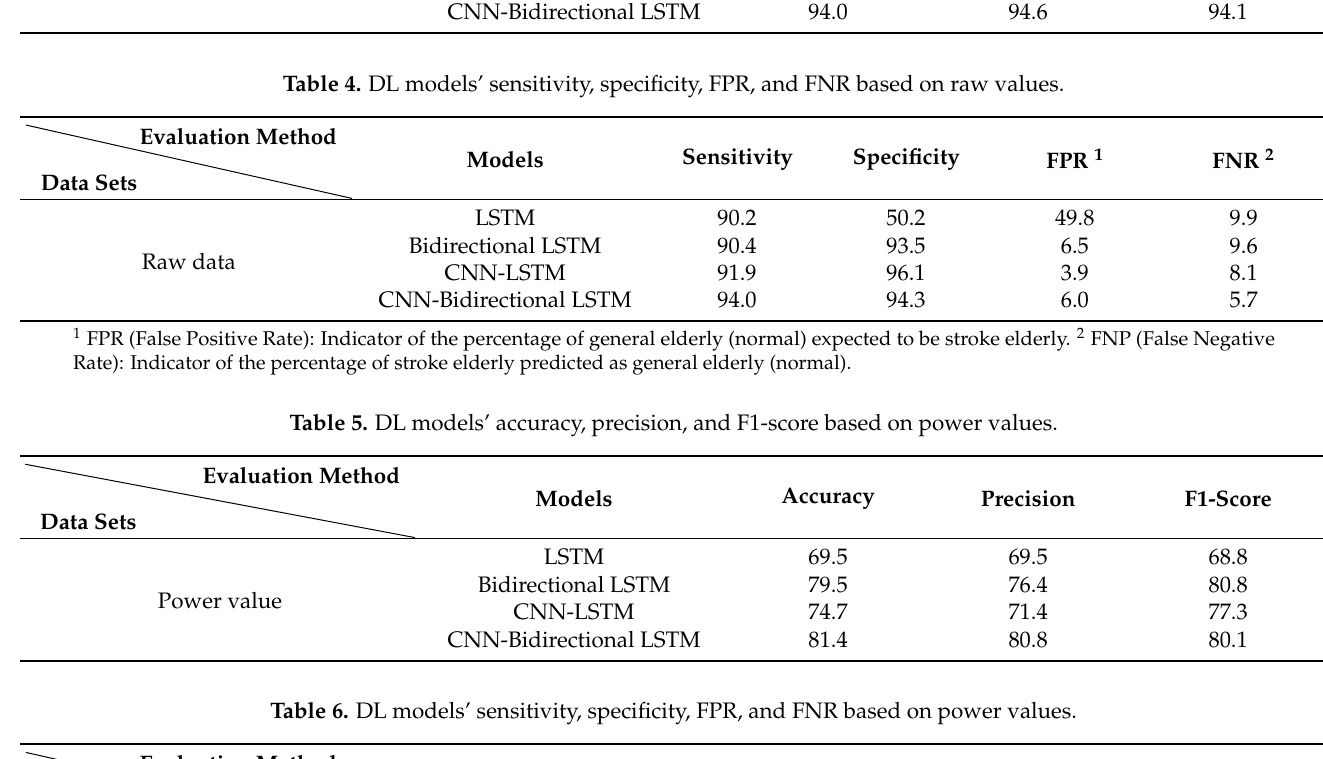
Table 6. DL models’ sensitivity, specificity, FPR, and FNR based on power values. SetsEvaluation Data